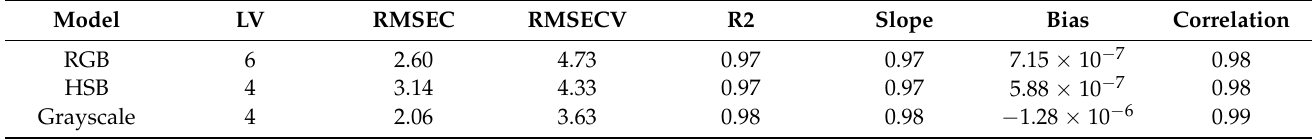
Table 20. Calibration model